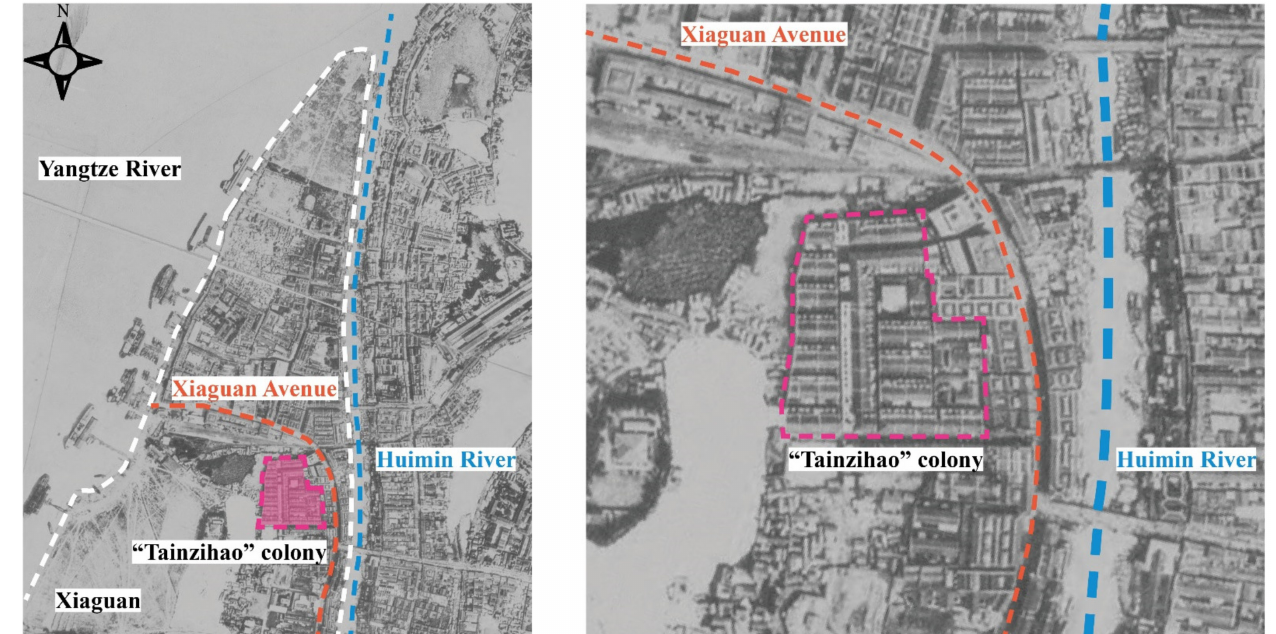
Figure 4. Aerial images for Xiaguan and the “Tianzihao” colony of